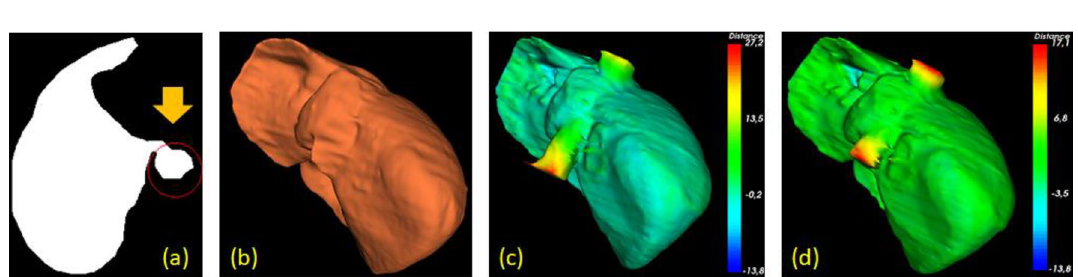
Table 8. A comparison of evaluation metrics and overall score between labeled and unlabeled datasets. The bold means the best values in each column.